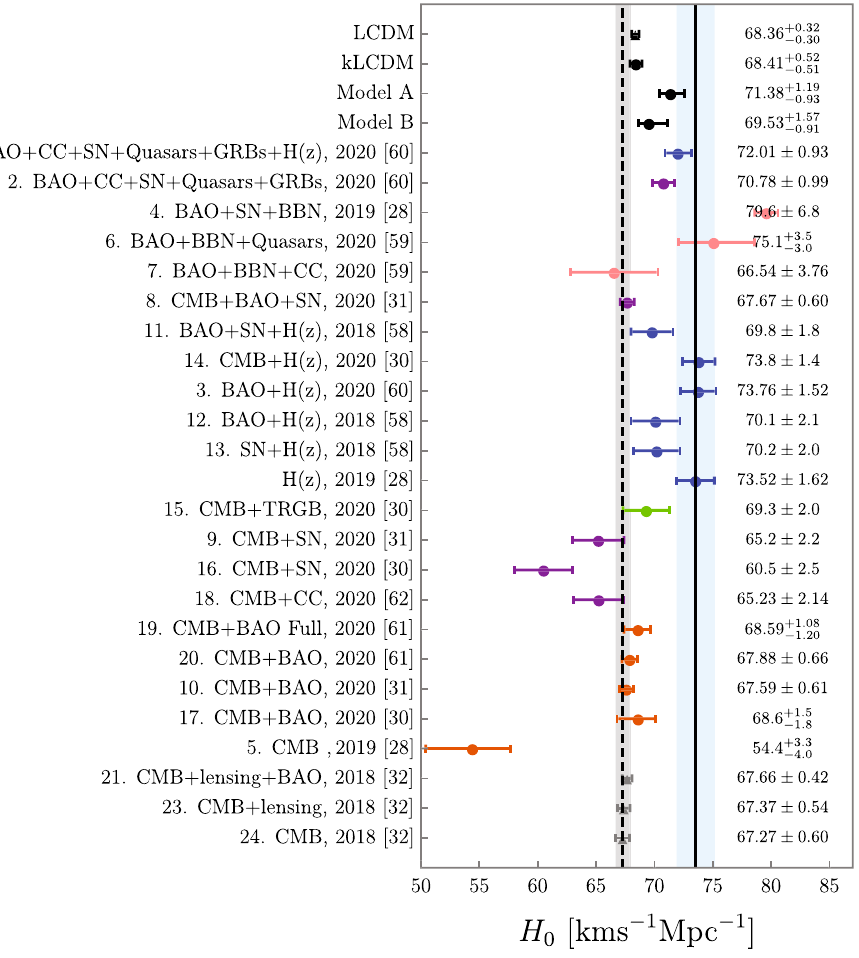
Fig. 2 Constraints on the Hubble constant H 0 at 1 σ CL obtained by different measurements vs. our constraints for the models A , B , LCDM, and kLCDM, using all the data sets in Table 1. In the different measurements, we use all the non-flat universe analysis (their companions with the same left numbers in Fig. 3) except the H ( z ) data [28] and the bottom three data [32], and the full analysis (without priors) for all the CMB data, in contrast to our analysis with the CMB priors. The grey vertical band corresponds the value H 0 = 67 . 27 ± 0 . 60 km s − 1 Mpc − 1 as reported by Planck 2018 team [32] within a LCDM scenario. The blue vertical band corresponds to the value H 0